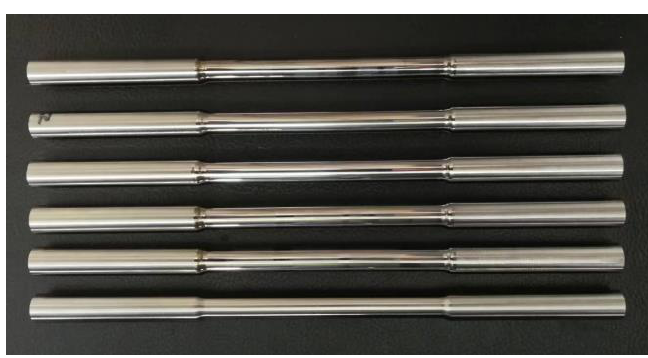
Figure 3. Morphology of samples after surface ultrasonic rolling. Table 2. Parameters of surface ultrasonic rolling treatment using single-factor variable method.